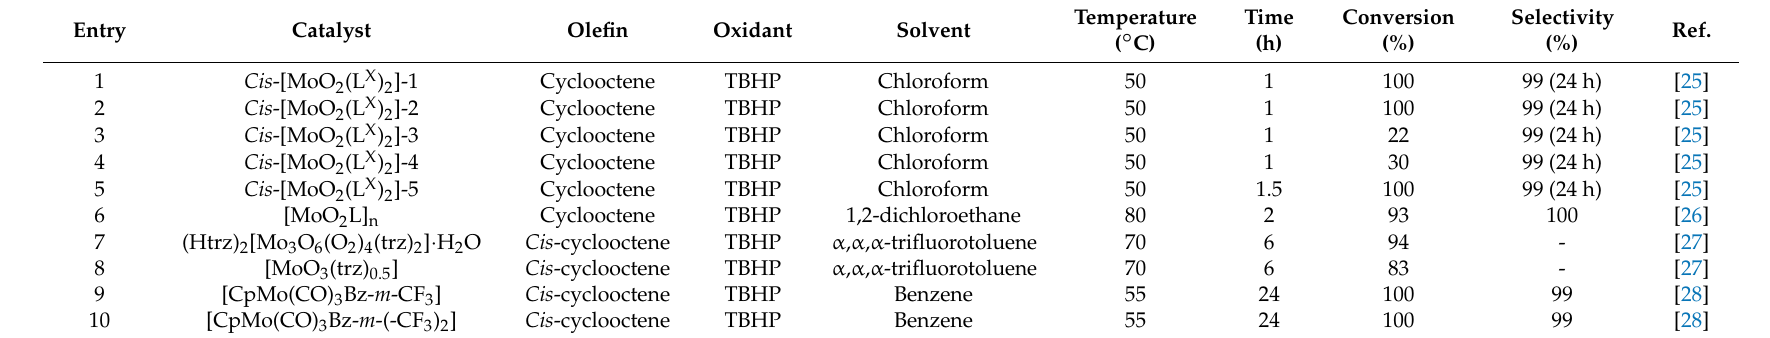
Table 1. Results of epoxidation reactions by using homogeneous molybdenum-based